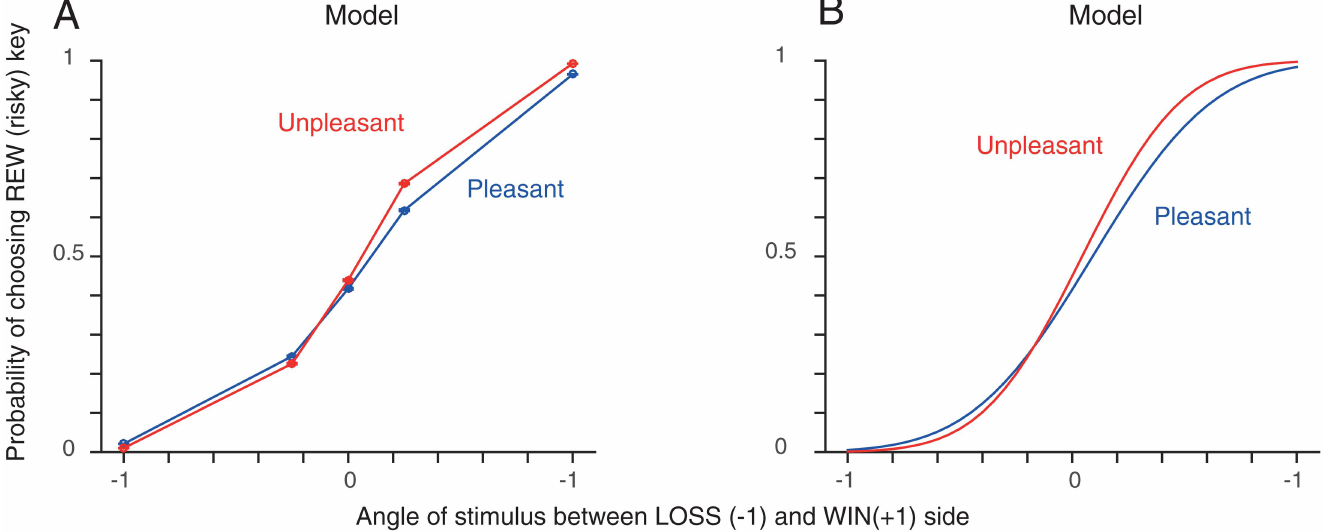
Fig 6. Model results for Session 1. A . Model simulation results with the estimated parameters m i ’s (Session 1). The model captures the asymmetry that is seen in the data (see Fig 3). The model was simulated in the same conditions(Session 1) as the actual experimentfor each participantfor 500 repetitions. The mean and the standard error of the mean of each participant group is shown. B . Model estimate with the estimated group means μ ML